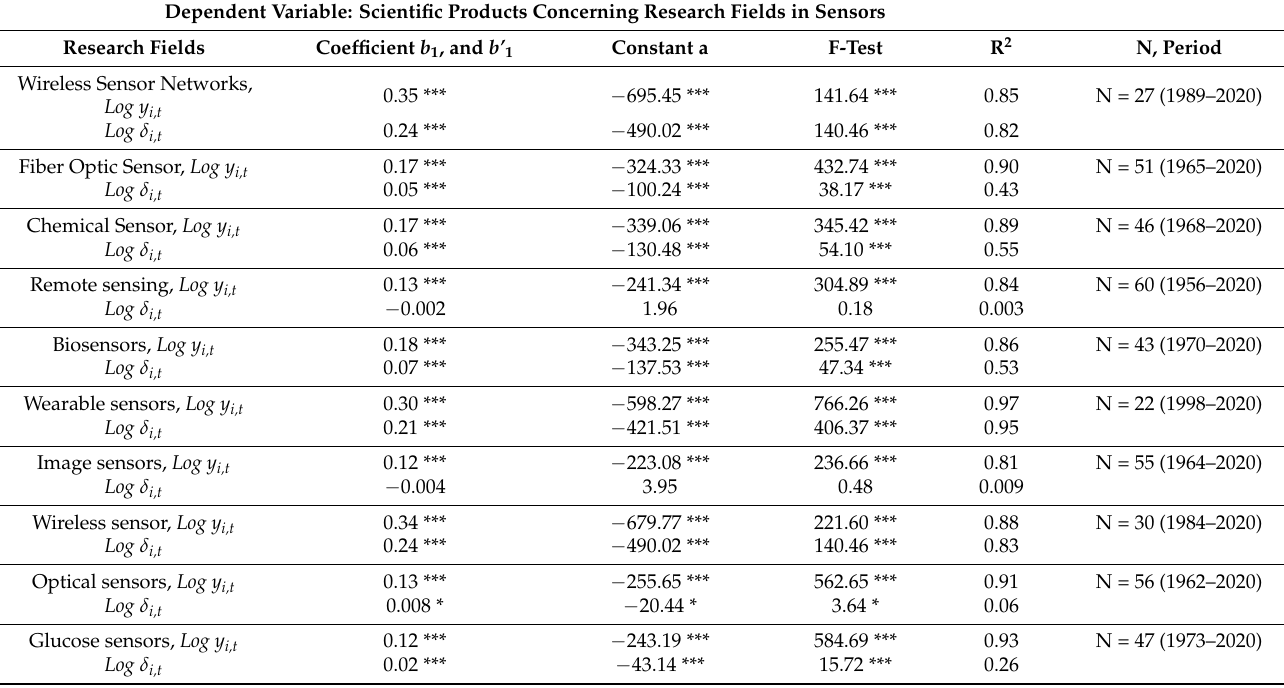
Table 1. Estimated relationships of scientific production in research fields of sensors as a function of time.